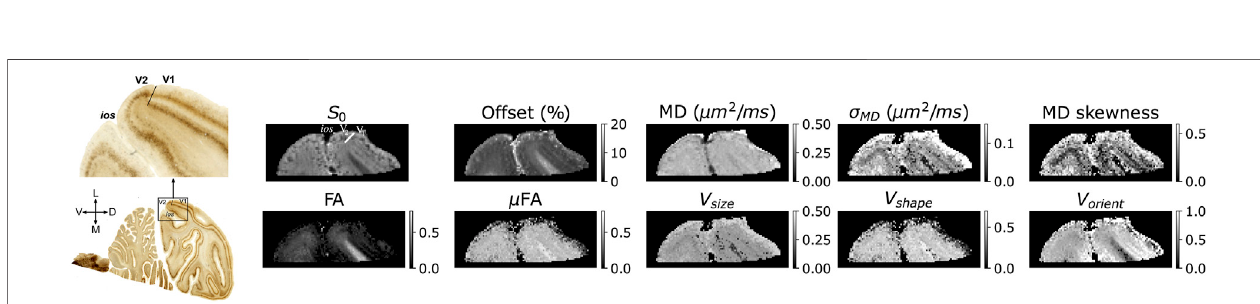
FIGURE 1 | DTD derived stains obtained in PDMS phantom showing zero heterogeneity. This includes S 0 - non-diffusion weighted image, signal offset, ε , expressed aspercentof S 0 ,MD — meandiffusivity,MDskewness — skewnessofMDspectrum,FA — fractionalanisotropy, μ FA — microscopic fractionalanisotropy,and V size , V shape , V orient — size, shape and orientation heterogeneity respectively.